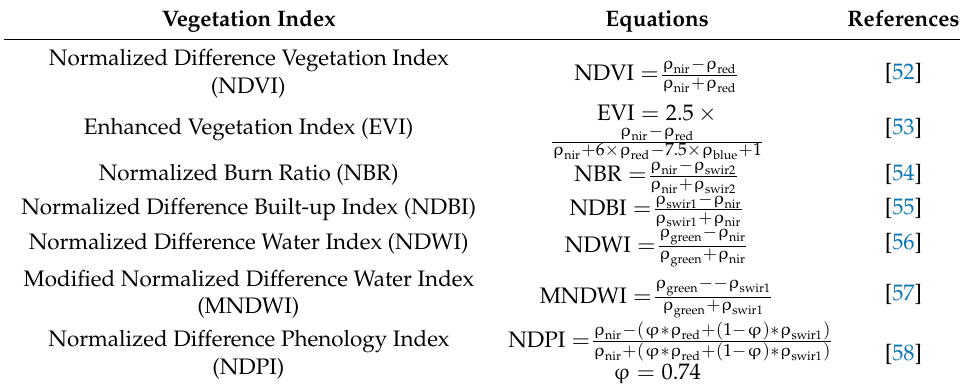
Table A1. Vegetation indices considered in this study.